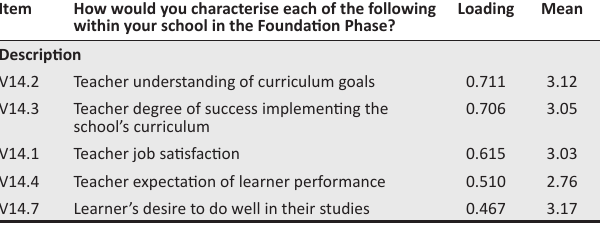
TABLE 7: The items, their loadings and mean scores contained in the factor ‘The school’s motivation of learner performance in the Foundation Phase’ (F1.1). Item